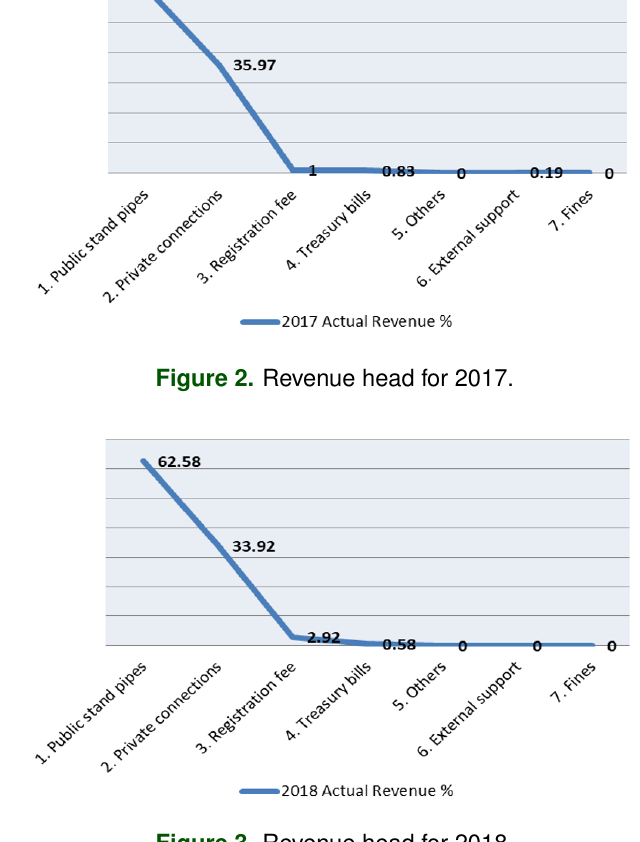
Figure 3. Revenue head for